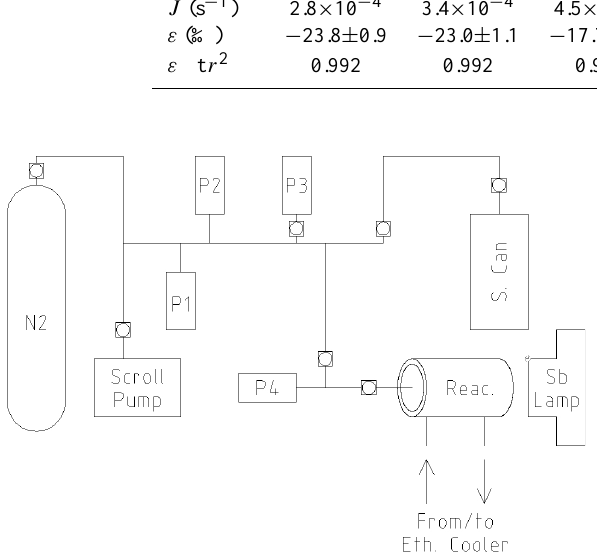
Fig. 1. Diagram of the photolysis setup at the School of Enviromen- tal Sciences at the University of East Anglia. P1–P4 indicate pres- sure sensors, S . Can the sample canister. During filling of the reac- tor, the source canister containing the unphotolyzed CFC-mixture is installed in place of the sample canister.